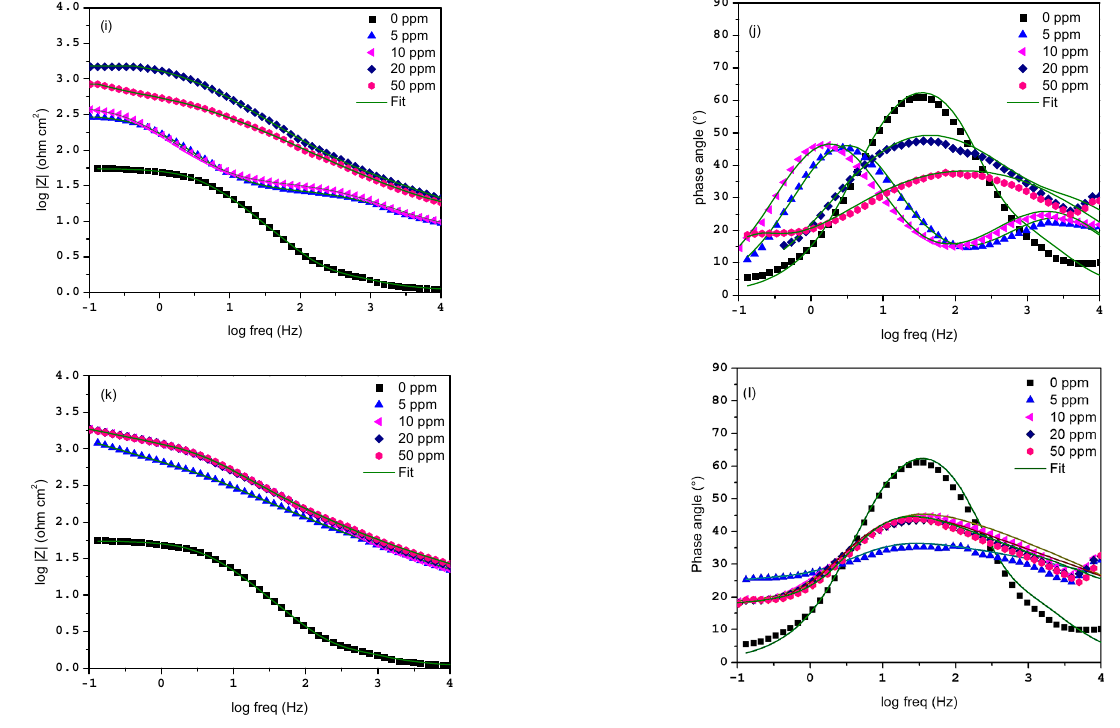
Figure 3. Bode diagram at different inhibitor concentrations ( a , b ) compound 3a , ( c , d ) compound 3b , ( e , f ) compound 3c , ( g , h ) compound 3d , ( i , j ) compound 3e , and ( k , l ) compound 3f in API 5L X70 steel immersed in HCl 1 M.